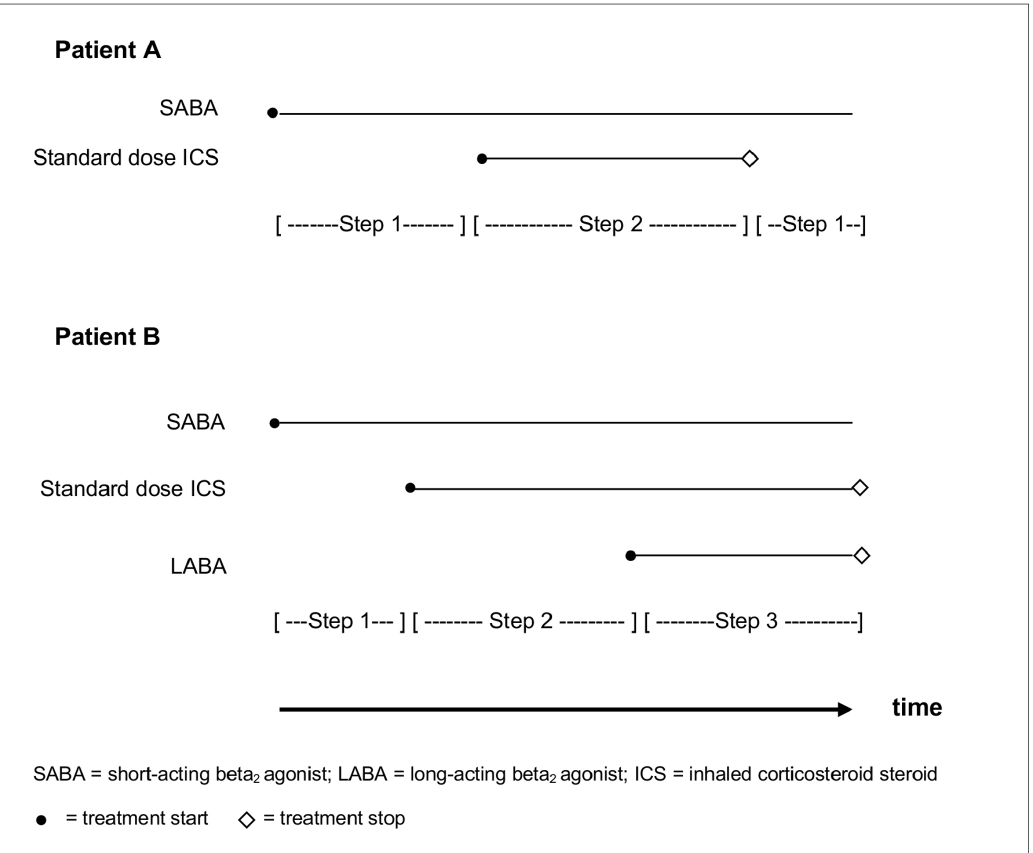
Figure 1. Example scenario for extracts of patients’ mapped prescription records and the allocated corresponding treatment steps.